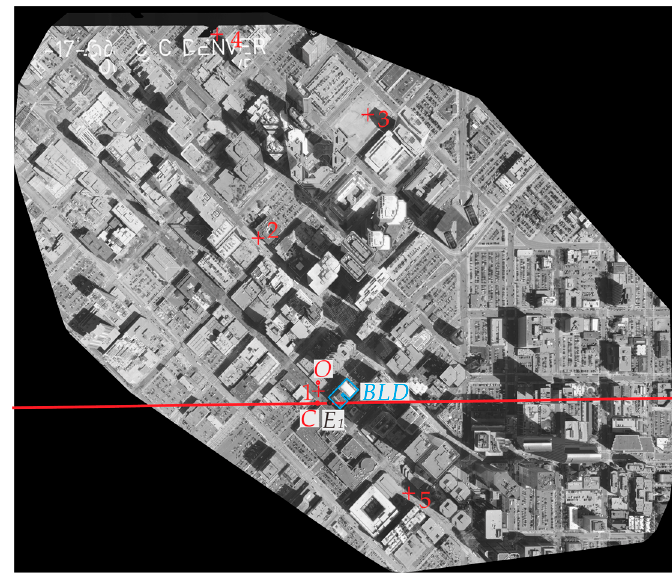
Figure 8. The accuracy analysis of the solar zenith angle and the solar altitude angle.